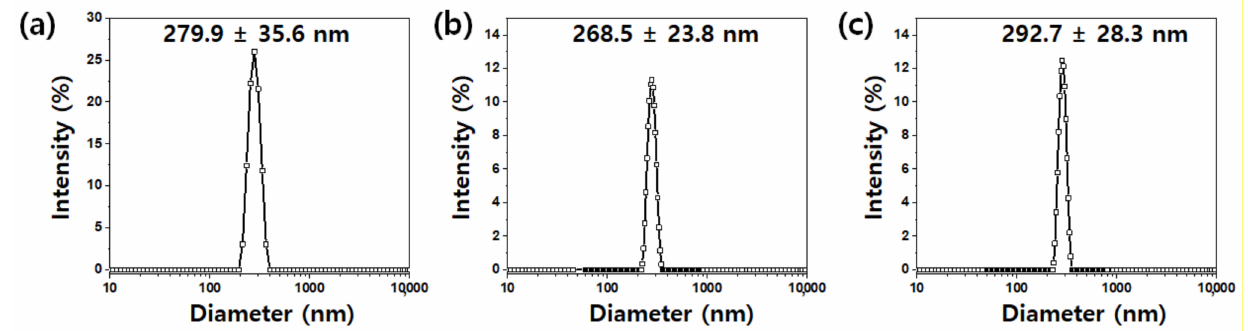
Figure 5. The particle size distribution by DLS: ( a ) HT, ( b ) DHT, and ( c ) NIC–DHT